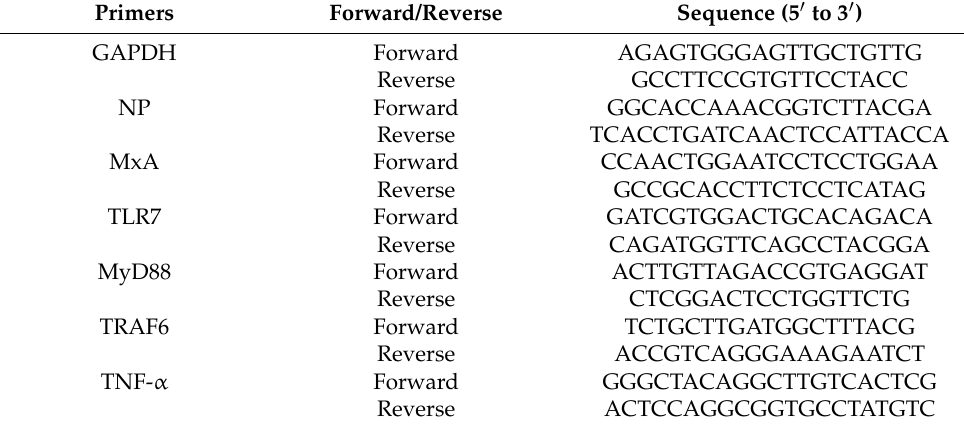
Table 1. Information for primer